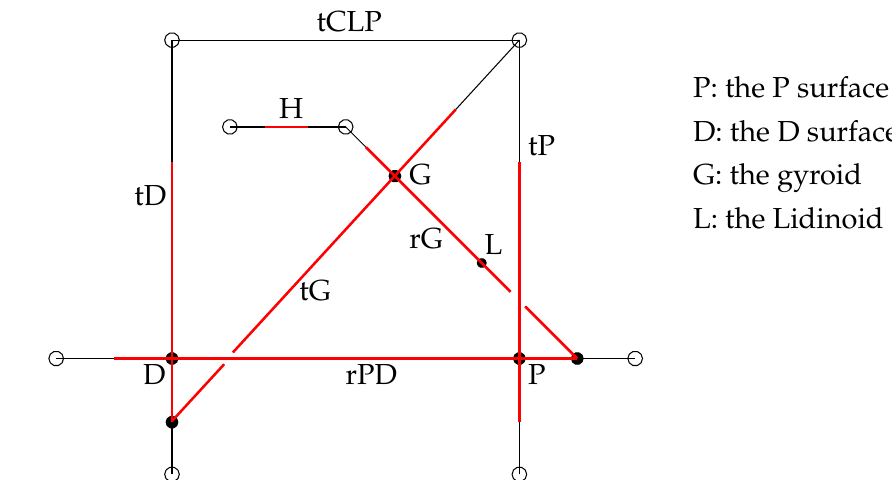
Figure 10. The diagram of the H family, the rPD family, the tP family, the tD family, the tCLP family, the rG family, the tG family (the red lines indicate minimal surfaces with index a = 1)